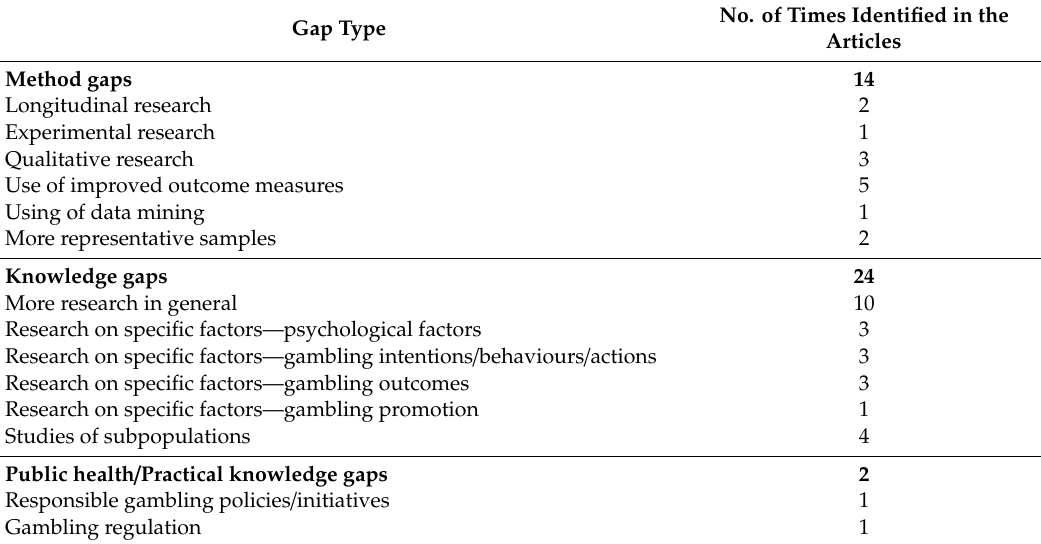
Table 7. Video gaming and gambling